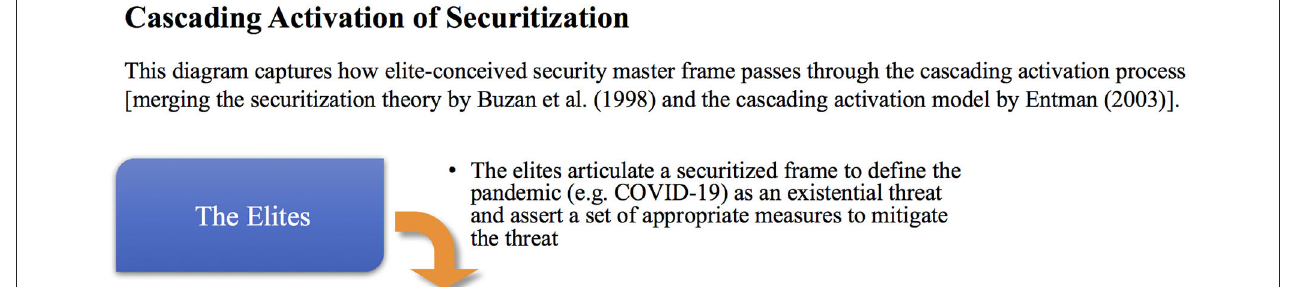
Frontiers in Communication |